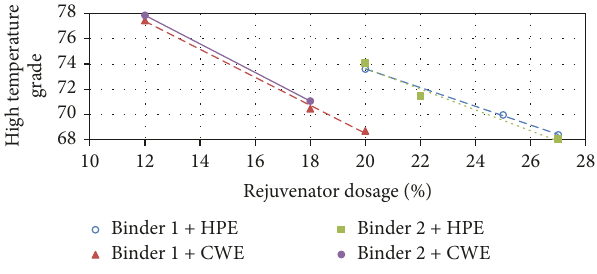
Figure 1: Softening curves for binder